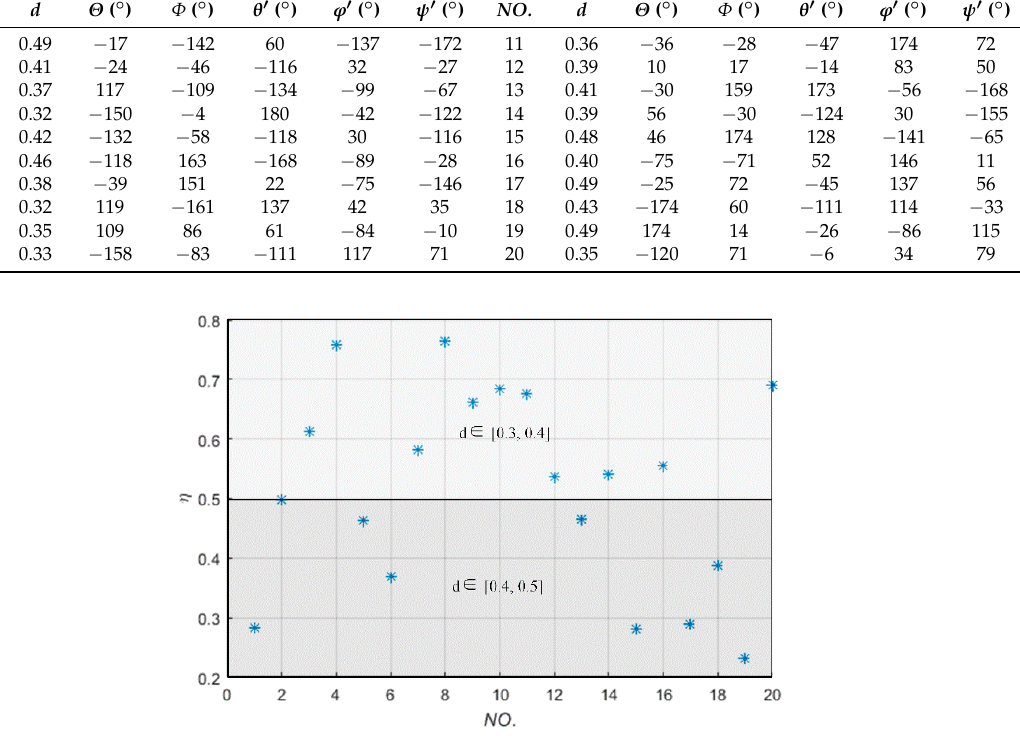
Figure 10. The power transfer efficiency versus the receiving coil with different locations and postures in the spherical shell.